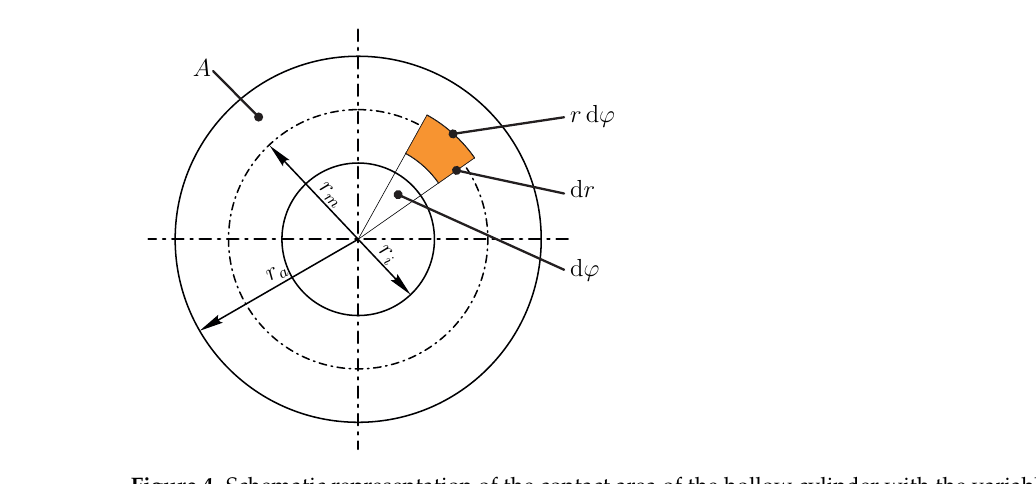
Figure 4. Schematic representation of the contact area of the hollow cylinder with the variables used for